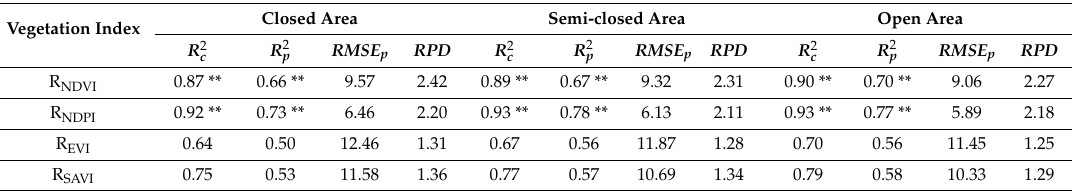
Table 3. Correlation between amount of dust absorption and vegetation indices. R 2 c —fitting